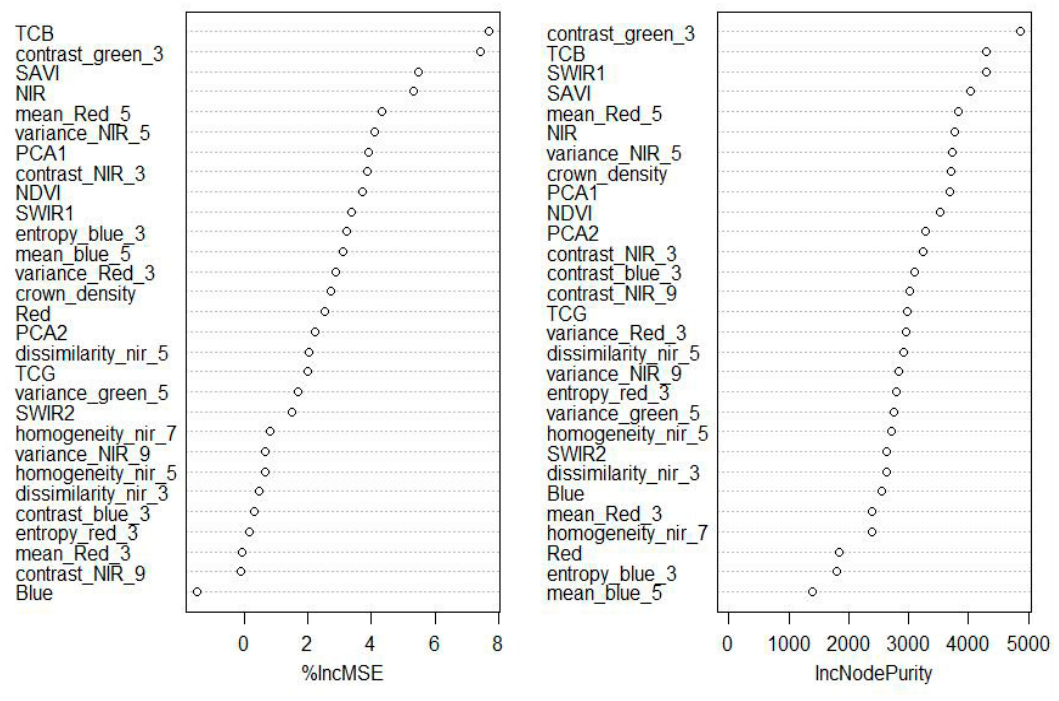
Figure 4. Importance of predictor variables.